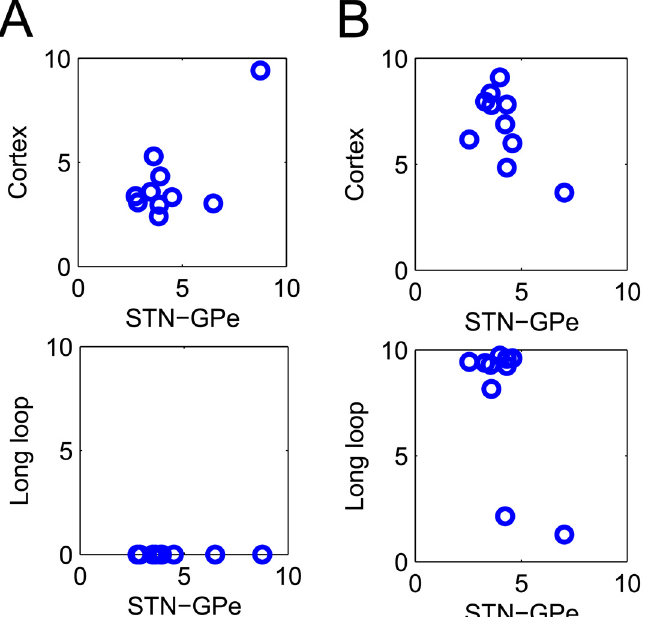
Fig 4. The top ten parameter sets found by the optimisation procedure. Of interest are the parameter values that represent the STN-GPe circuit, the cortex and the closed basal ganglia-cortical loop. The relationship between these values are shown in the two panels, where each circle represents a solution of the optimisation. A) Resonance model. B) Feedback